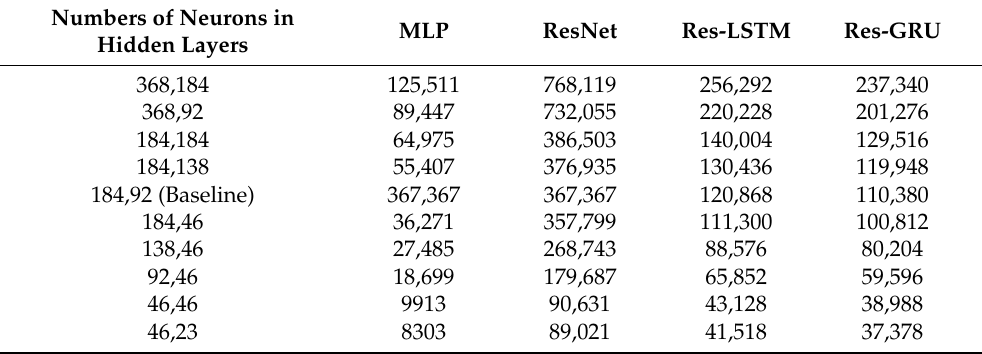
Table A11. Numbers of parameters of simplified or complicated MLP, ResNet, Res-LSTM and Res-GRU